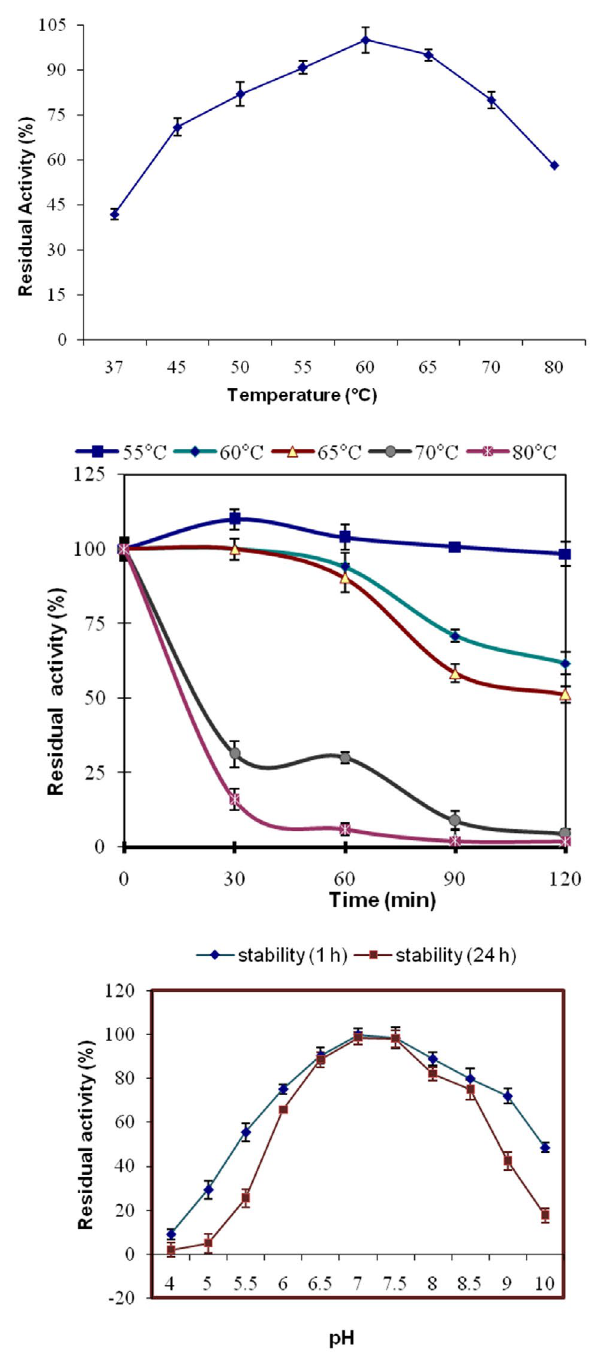
Fig. 3. (a) Effect of temperature on the activity of purified β-mannanase from P. thiaminolyticus. (b) Effect of temperature on thermal denaturation of β-mannanase After preincubation at 55°C (Squares), 60°C (filled diamonds), 65°C (filled triangles), 70°C (filled ovals) and 80°C (colored cross) for various lengths of time followed by enzyme assay at 60°C. 3 (c). Effect of pH on the stability of purified β-mannanase from P. thiaminolyticus. The pH stability was determined by measuring the residual activity after incubation at various pH values at 55°C for 1 h and 24